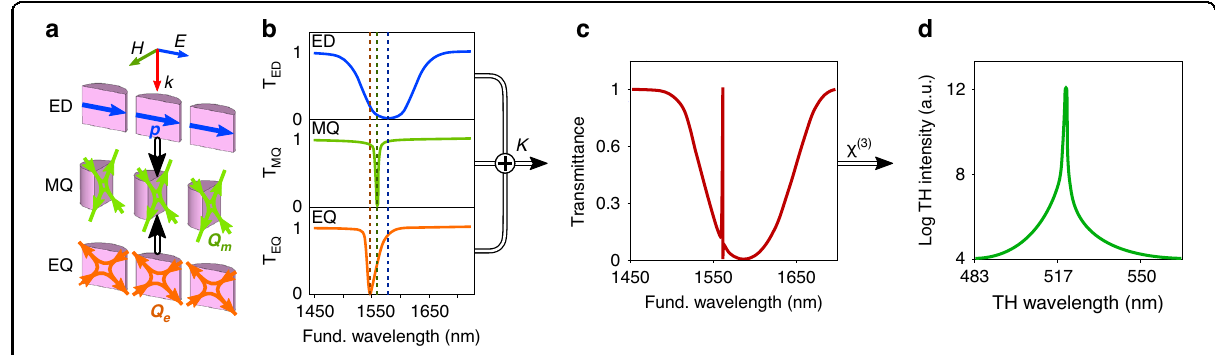
Fig. 3 The multi-mode Fano resonance mechanism. a Illustration of the enhanced third harmonic generation scheme by the Super-Fano resonance mechanism. This formation involving electric dipole, magnetic quadrupole, and electric quadrupole modes. b Transmittance spectra associated with the corresponding modes forming single resonances. c The resultant transmittance spectrum originated from coupling of these three modes with strength κ , forming the Fano-like sharp asymmetric resonance pro fi le. d The corresponding TH spectrum of high